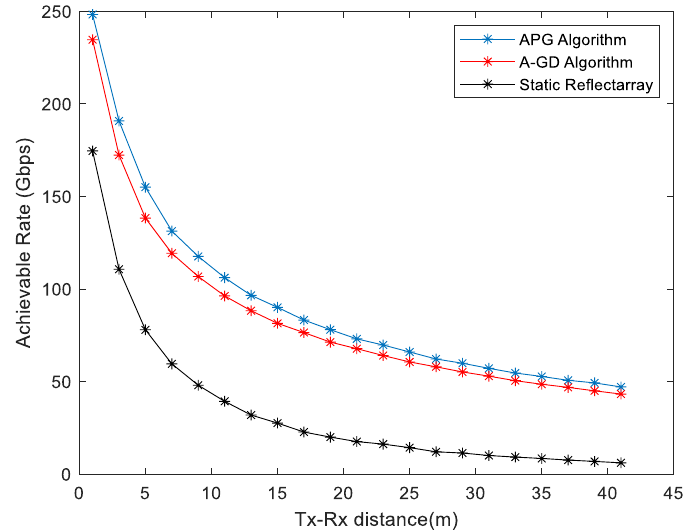
Figure 3. Achievable rate versus distance between BS – User for various schemes.